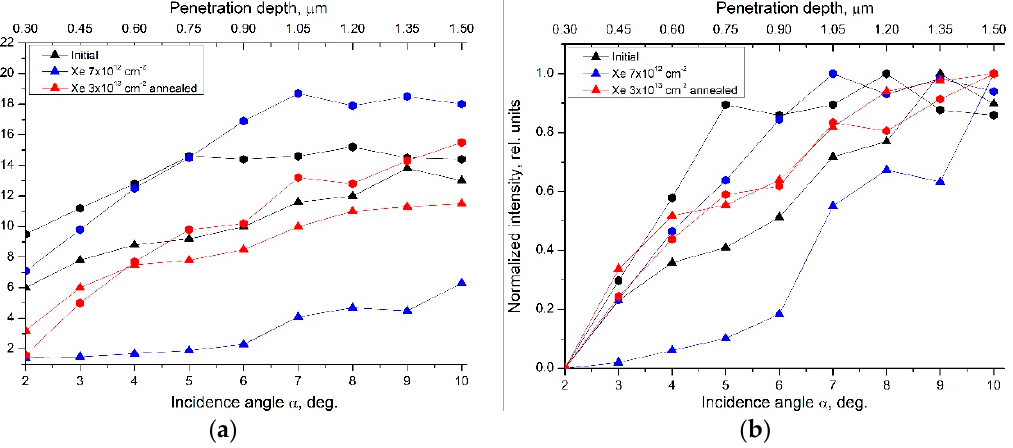
Figure 10. Analysis of the GIXRD results: ( a ) dependence of the intensity of the XRD peaks from the YPO 4 :Gd phase (triangles) and the graphite phase (circles) on the primary beam incidence angle on the sample; ( b ) the same normalized in intensity to the interval (0;1). Black markers—initial sample, blue markers—after irradiation (F = 7 × 10 12 cm − 2 ), red markers—after irradiation and annealing at 700 °C.